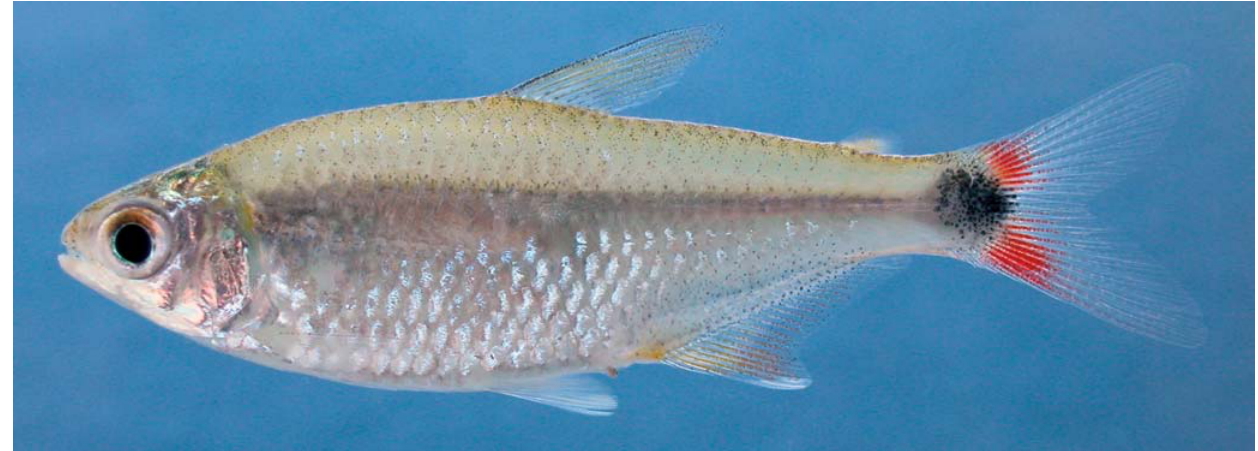
Fig. 4. Odontostilbe fugitiva from lower río Ucayali drainage. Photo by William Crampton (Ucamara Project).